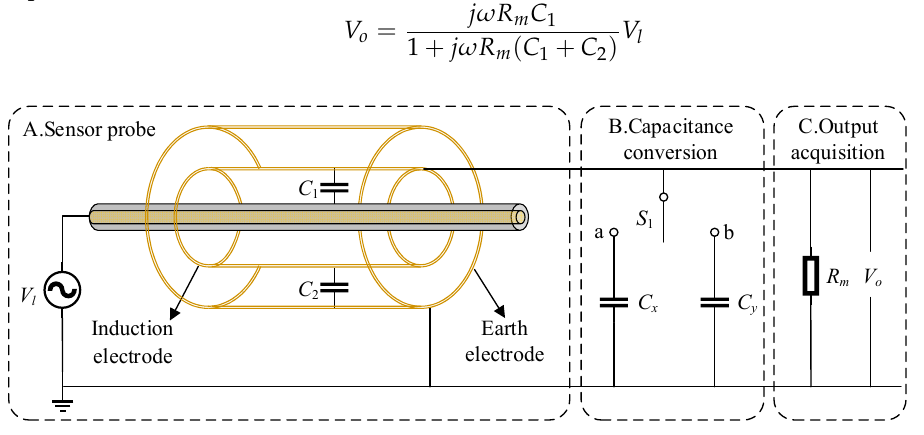
Figure 1. Contactless voltage measurement model based on electric field coupling.